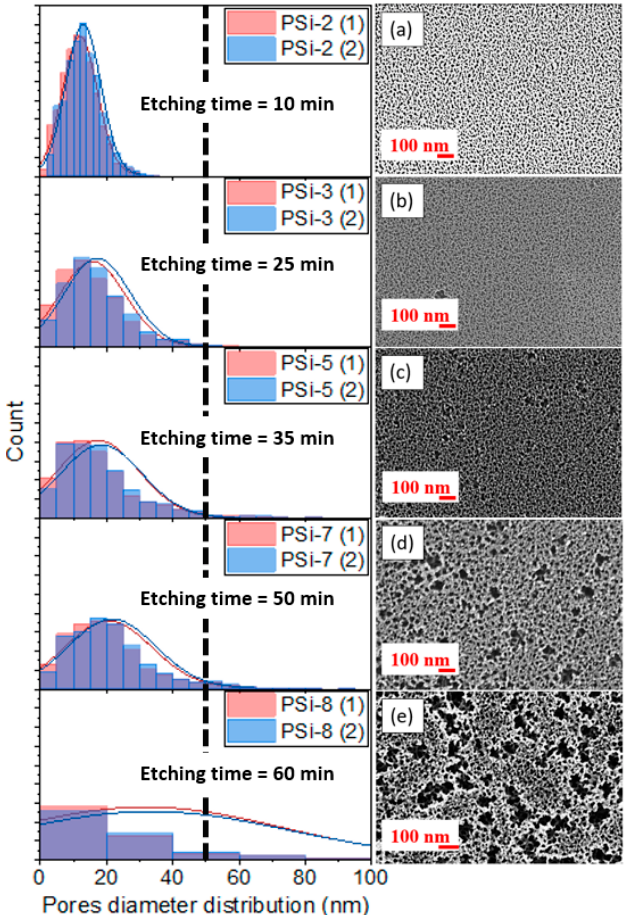
Figure 2. SEM images of PSi surface for different thicknesses: ( a ) PSi-2, ( b ) PSi-3, ( c ) PSi-5 ( d ) PSi-7, and ( e ) PSi-8, with a current density of 100 mA/cm² and pore distribution for each sample. The limitation (dark dashes) indicates the boundary between mesopores and macropores. The Normal law representation shows the mode for each histogram. The analysis was performed twice: (1) in red and (2) in blue; both are represented for each sample.